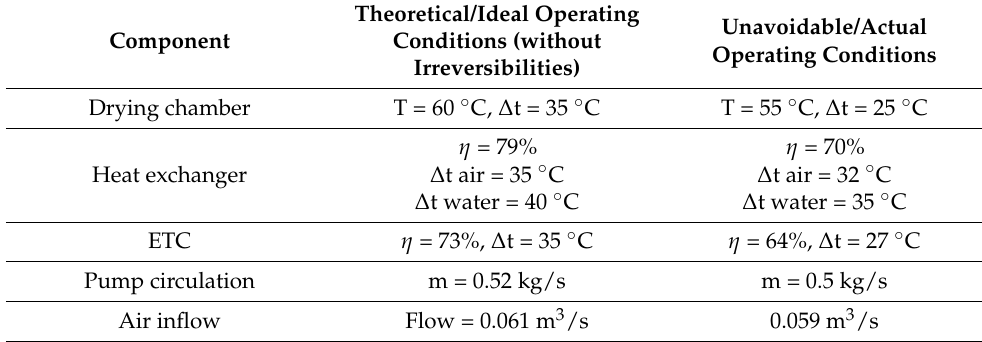
Table 3. Assumption for calculating exergetic parameters under theoretical and operating (unavoid- able) conditions.